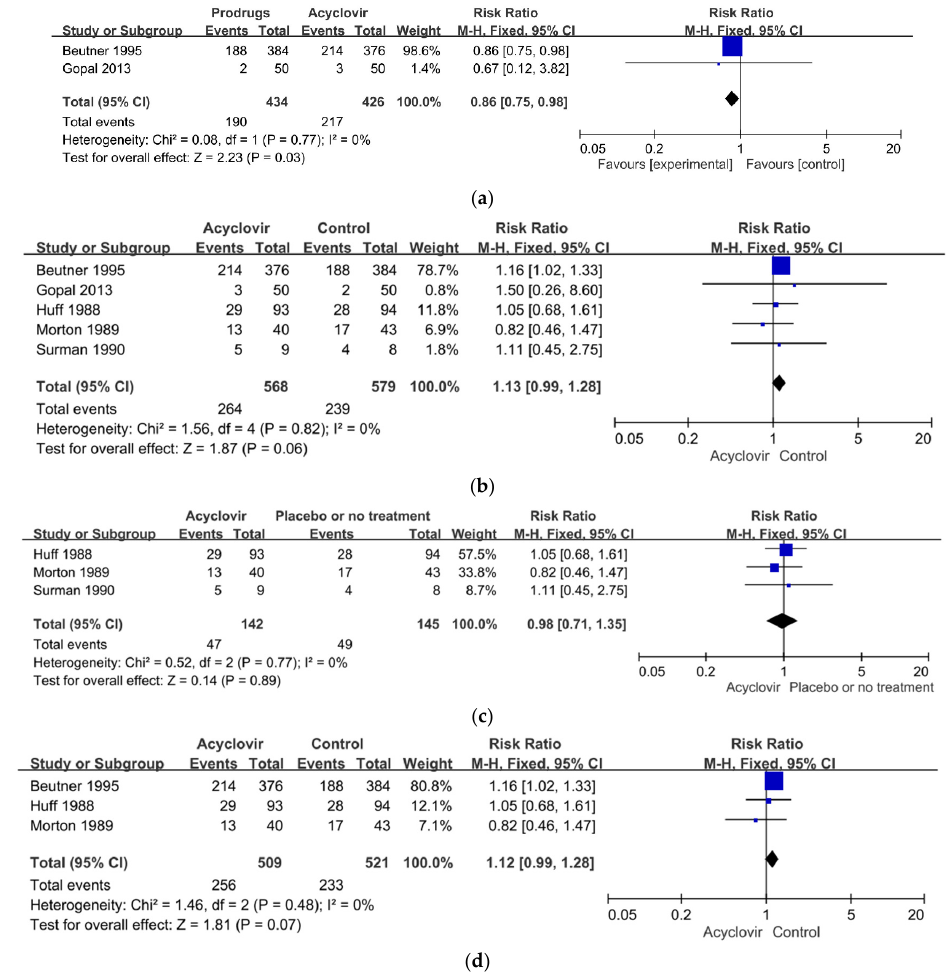
Figure 4. ( a ) Forest plot comparison: prodrugs versus acyclovir in relieving of PHN within one month of the onset of the acute herpetic rash. ( b ) Forest plot of comparison: acyclovir versus the control including the placebo or prodrugs in the relieving of PHN within one month after the onset of the acute herpetic rash. ( c ) Forest plot of comparison: acyclovir versus the placebo in the relieving of PHN in one month after the onset of the acute herpetic rash. ( d ) Sensitivity analysis: acyclovir versus the control group excluding the high-risk studies in relieving of PHN within one month of the onset of the acute herpetic rash.